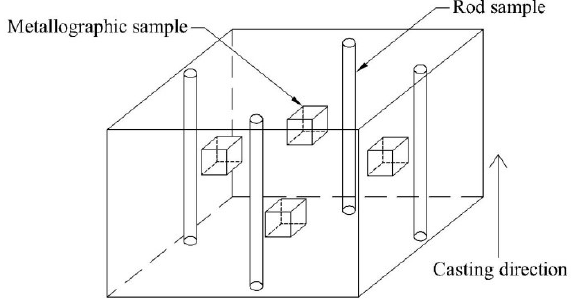
Figure 3. Schematic diagram of sampling.